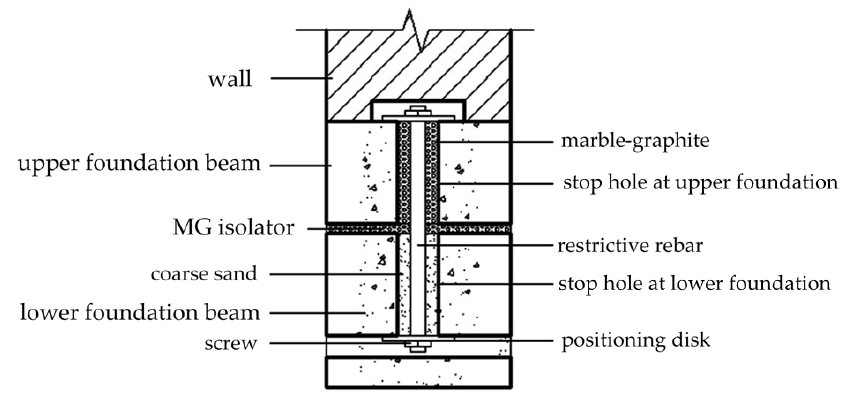
Figure 2. Specimen Design, RC: reinforced concrete; MG: marble-graphite.